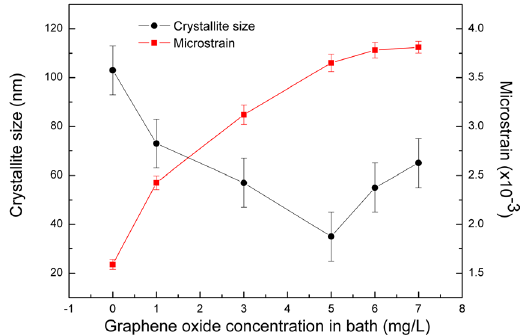
Figure 6. Crystallite size and microstrain of the RGO/Cu composites at different GO loading in